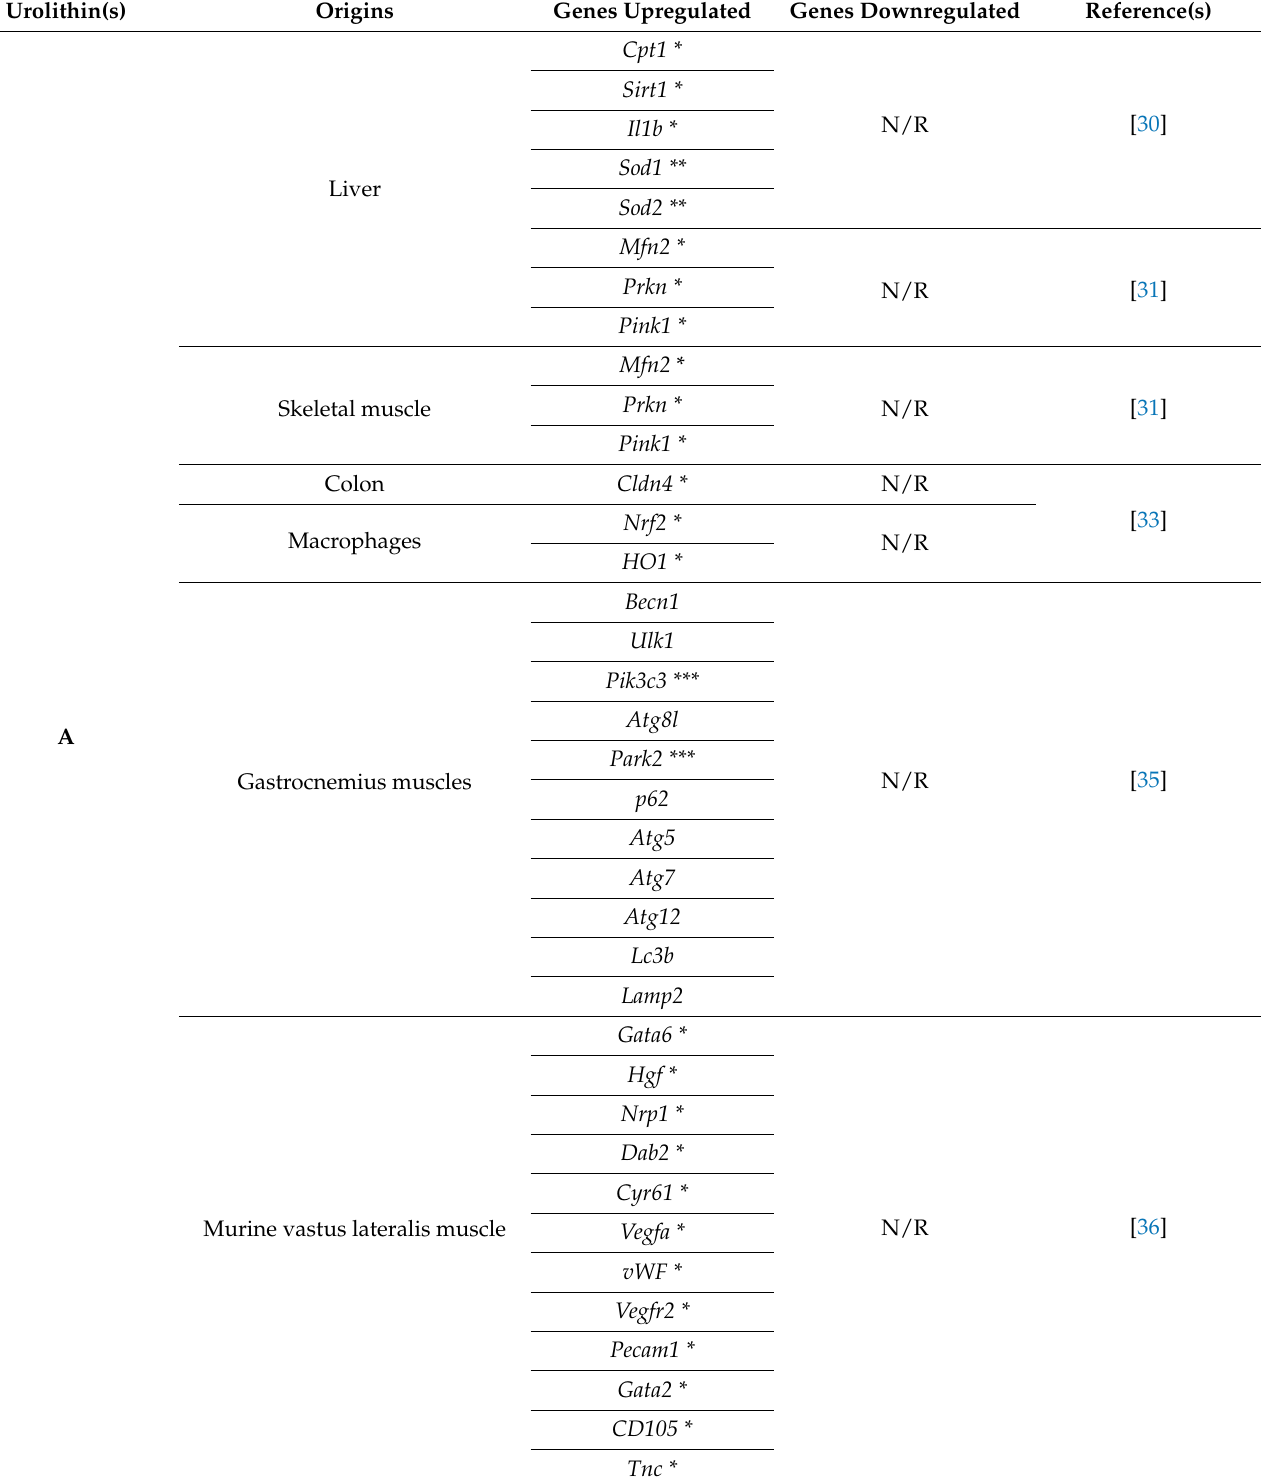
Table 2. Gene expressions regulated by urolithin(s) reported in the included in vivo